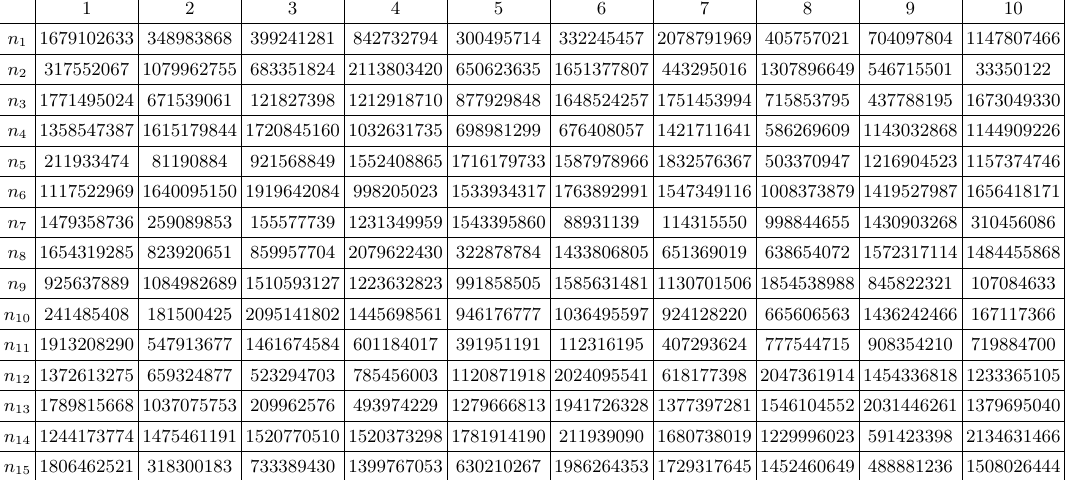
Table 2 . Numerical values for the unshifted kinematic factors of the 5-point